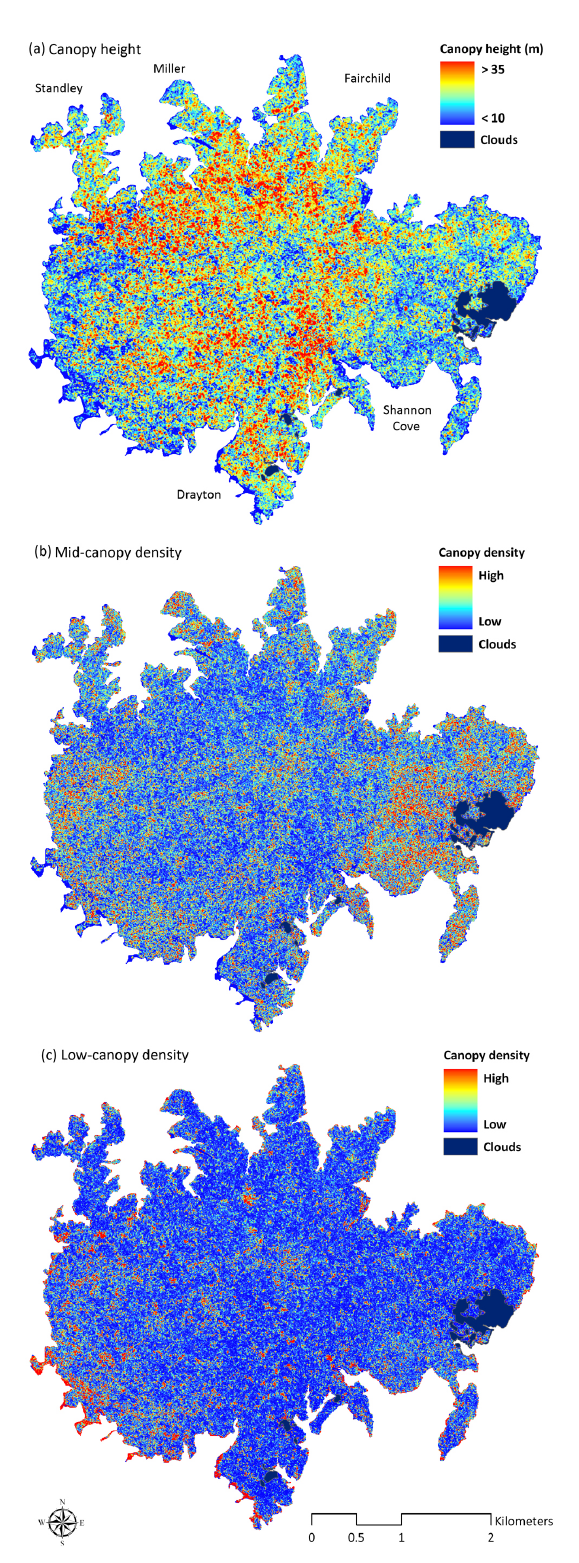
Fig. 2. LiDAR-derived (a) top-of-canopy height, (b) canopy-filled space at mid (12–17m) and (c) low (2–7m) levels (5m